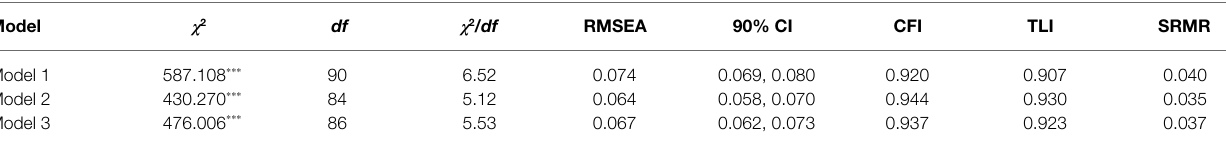
TABLE 2 | CFA results of the three competing